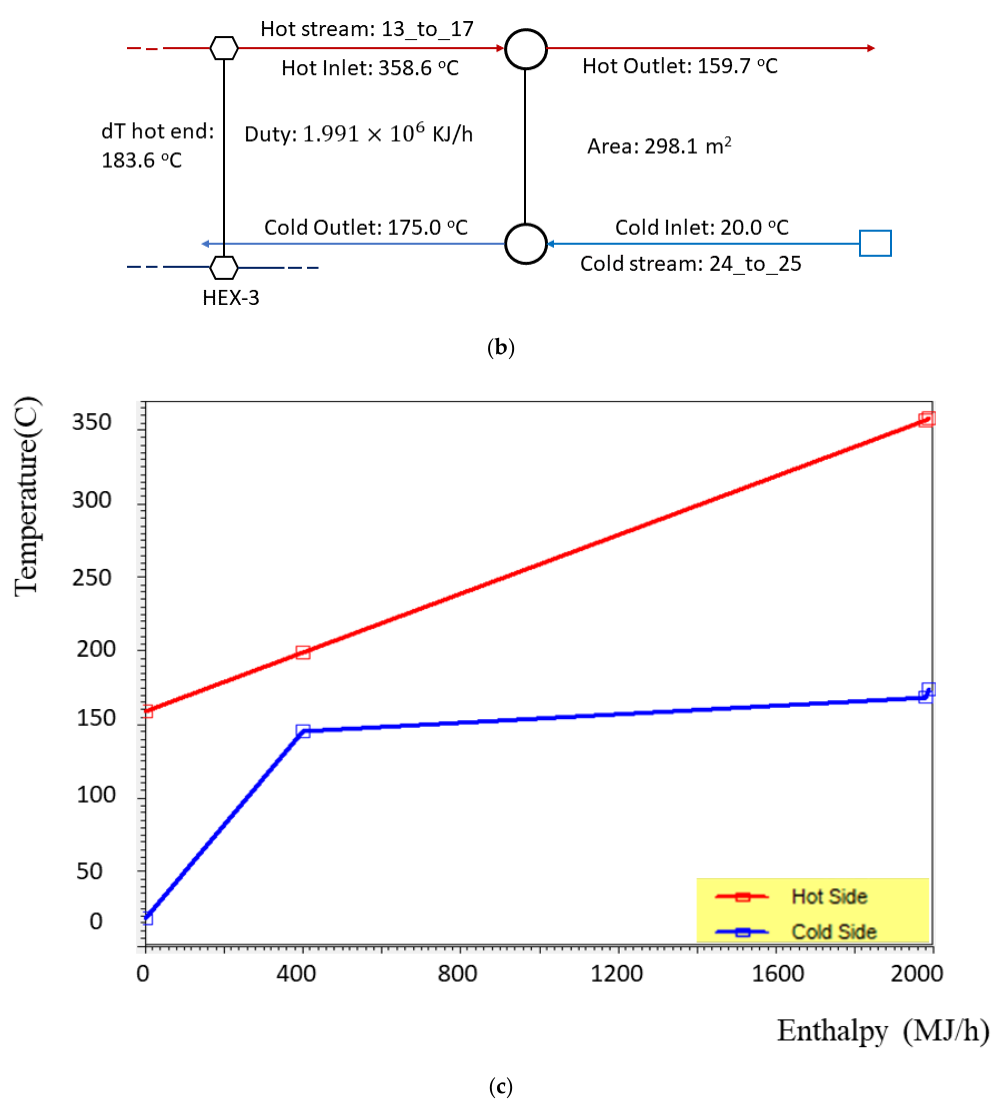
Figure 2. The temperature distribution of the EGB. ( a ) Temperature regions in the EGB. ( b ) Connec- tivity. ( c ) Temperature–enthalpy plot.